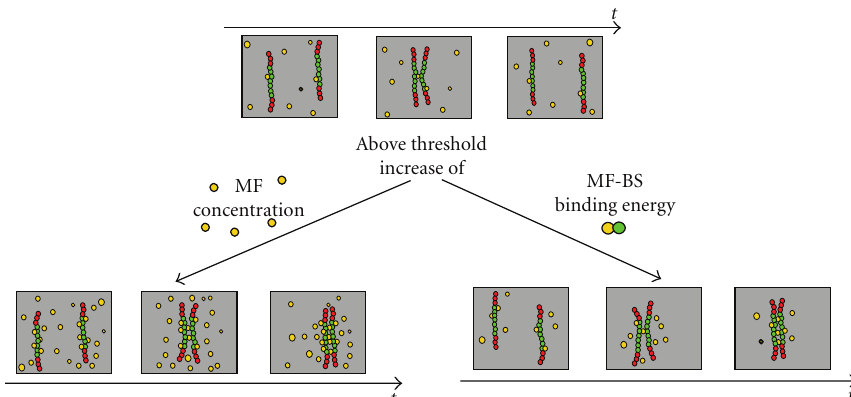
Figure 1: A molecular factors-mediated interaction produces DNA colocalization. The pictures schematically show how DNA segments at equilibrium colocalize, when the concentration of Molecular Factors (MFs, yellow beads) or their a ffi nity for the Binding Sites (BSs, green beads) exceeds a threshold value. Actually, when this happens, thermodynamically stable “MF bridges” are built between the DNA